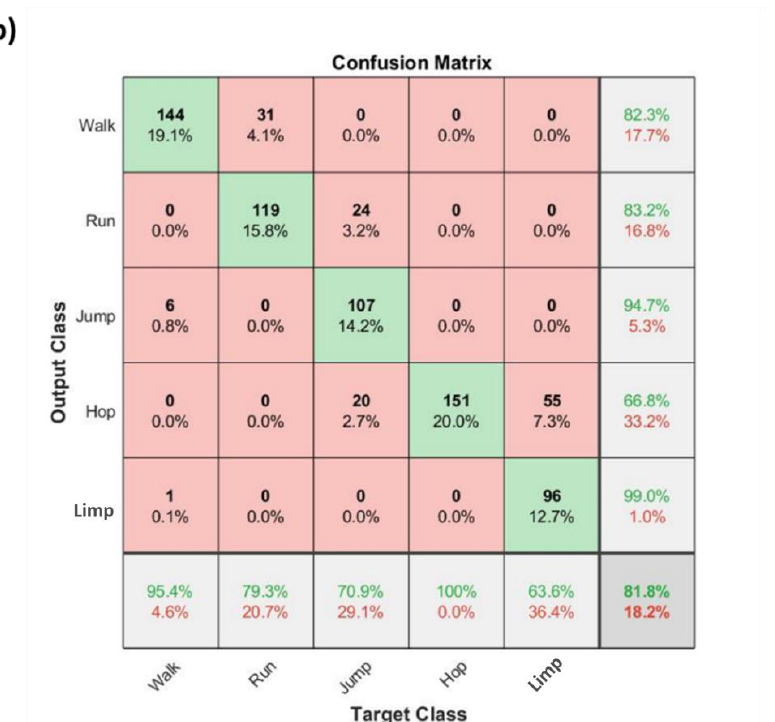
Figure 6. Classification of the SPMS motion identification by using machine learning via LSTM arithmetic. ( a ) The LSTM simplified architecture. ( b ) Confusion matrix for biomechanical motion-level classification corresponding to walking, running, jumping, hopping, and limping.